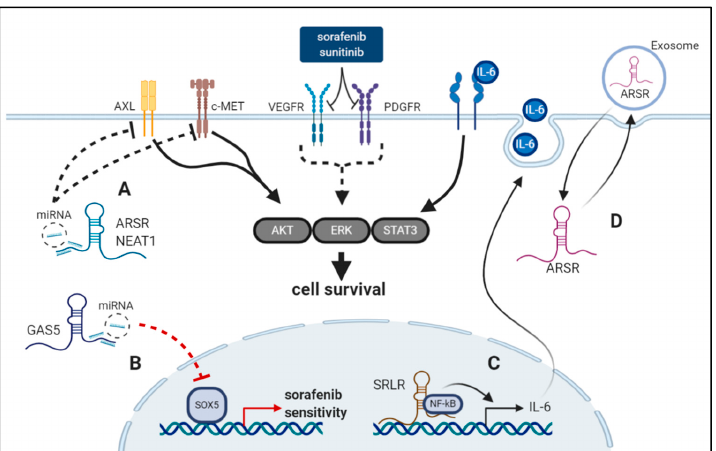
Figure 1. Examples of long non-coding RNAs (lncRNAs) and mechanisms of drug resistance in renal cell carcinoma (RCC). ( A ) lncRNA Nuclear Paraspeckle Assembly Transcript 1 (NEAT1) sponges miR-34a and as a result, increases c-MET expression. ( B ) lncRNA growth arrest specific transcript 1 (GAS5) sponges miR-21 thereby preventing it from targeting SRY-Box transcription factor 5 (SOX5) leading to increased sensitivity to sorafenib. ( C ) lncRNA sorafenib resistance-associated lncRNA in RCC (SRLR) recruits NF- κ B to the interleukin 6 (IL-6) promoter, resulting in increased autocrine IL-6 secretion and bypassing of blocked vascular endothelial growth factor receptor (VEGFR) and platelet derived growth factor receptor (PDGFR). ( D ) lncRNA activated in RCC with sunitinib resistance (ARSR) can be secreted via exosomes from sunitinib resistant cells and can be incorporated from sunitinib sensitive cells, thereby transferring drug resistance. ARSR sponges miRNAs and consequently promotes AXL and c-MET expression promoting sunitinib resistance. (created with Biorender.com).